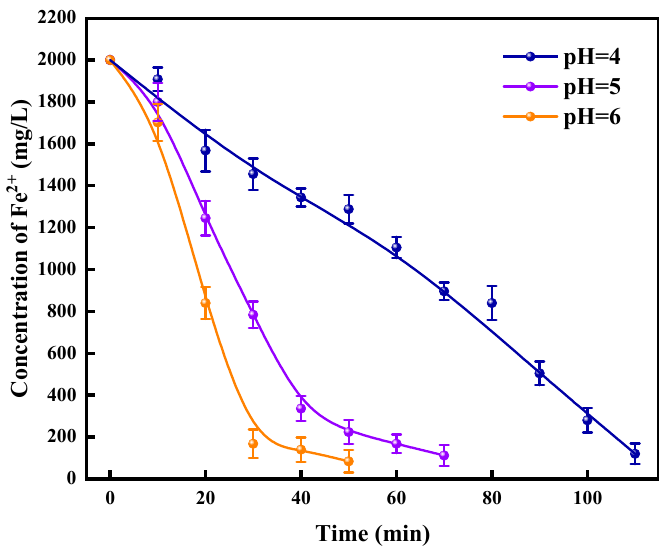
Figure 4. Influence of solution pH values on the oxidation of ferrous ions.